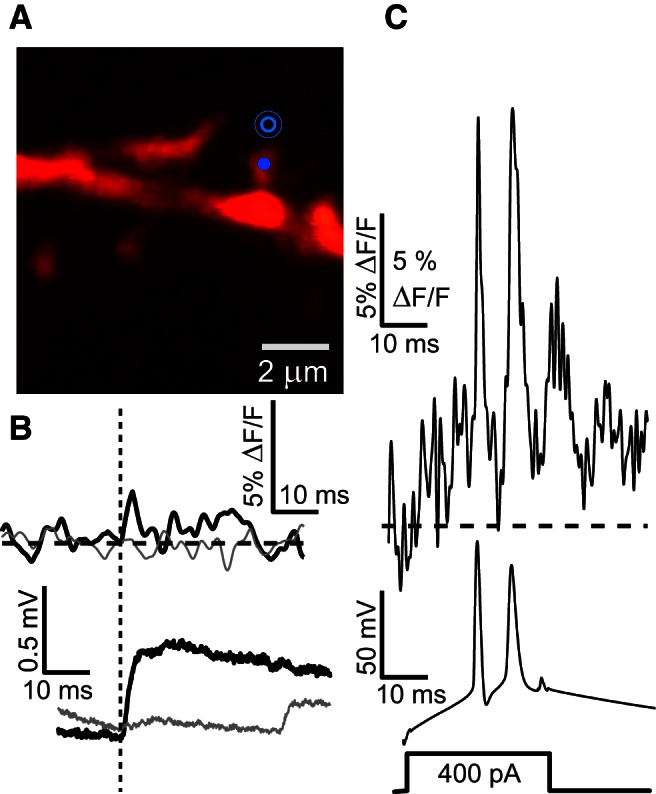
Uncaging responses in spines that are below the optical measurement threshold: clear optical bAP measurements serve as positive controls and for signal calibration. A–C, Same as Figure 1 on a different dendrite with target spine 52 μm from soma. A clear soEPSP is seen in B (0.5 mV peak), but no clear optical spEPSP is seen in B (top; no fit is made), whereas at the same time bAPs are clearly measureable optically in C (top; serves as positive control). Averages of N = 10 sweeps APs, 18.3% peak. Average of N = 10 sweeps uncaging and control, σnoise = 0.3%.